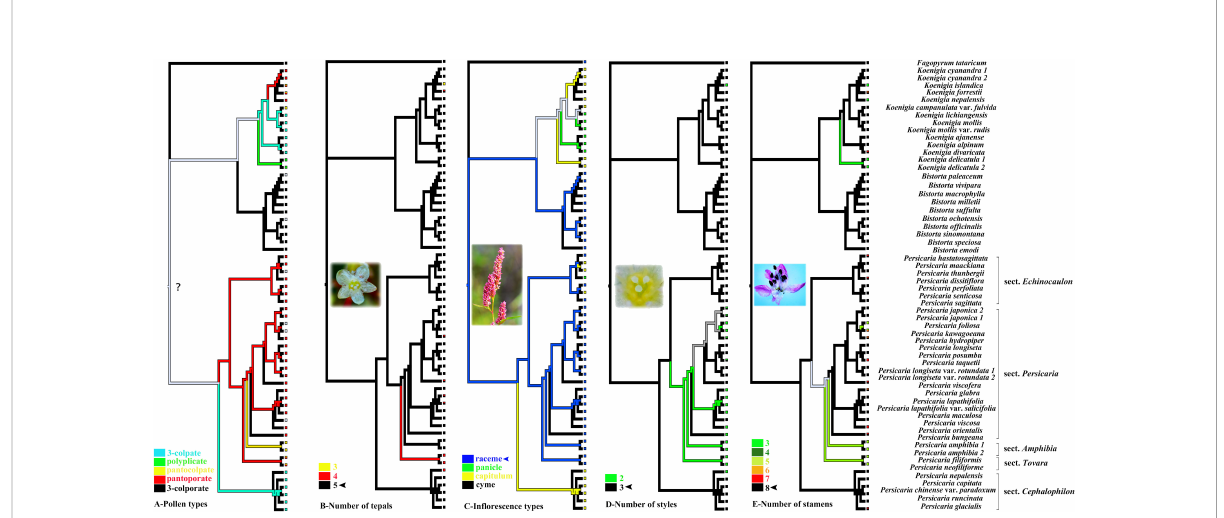
FIGURE 3 Ancestral state reconstruction of pollen types, the number of tepals, in fl orescences types, the number of styles and stamens based on relationships implied by the RAxML tree. The ink line diagram represents the reconstructed ancestral state. The question mark indicates uncertainty. Photo credits: Dong-Ling